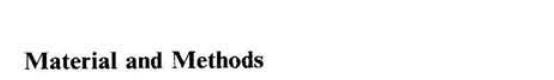
Table 1. Pteridines in amniotic